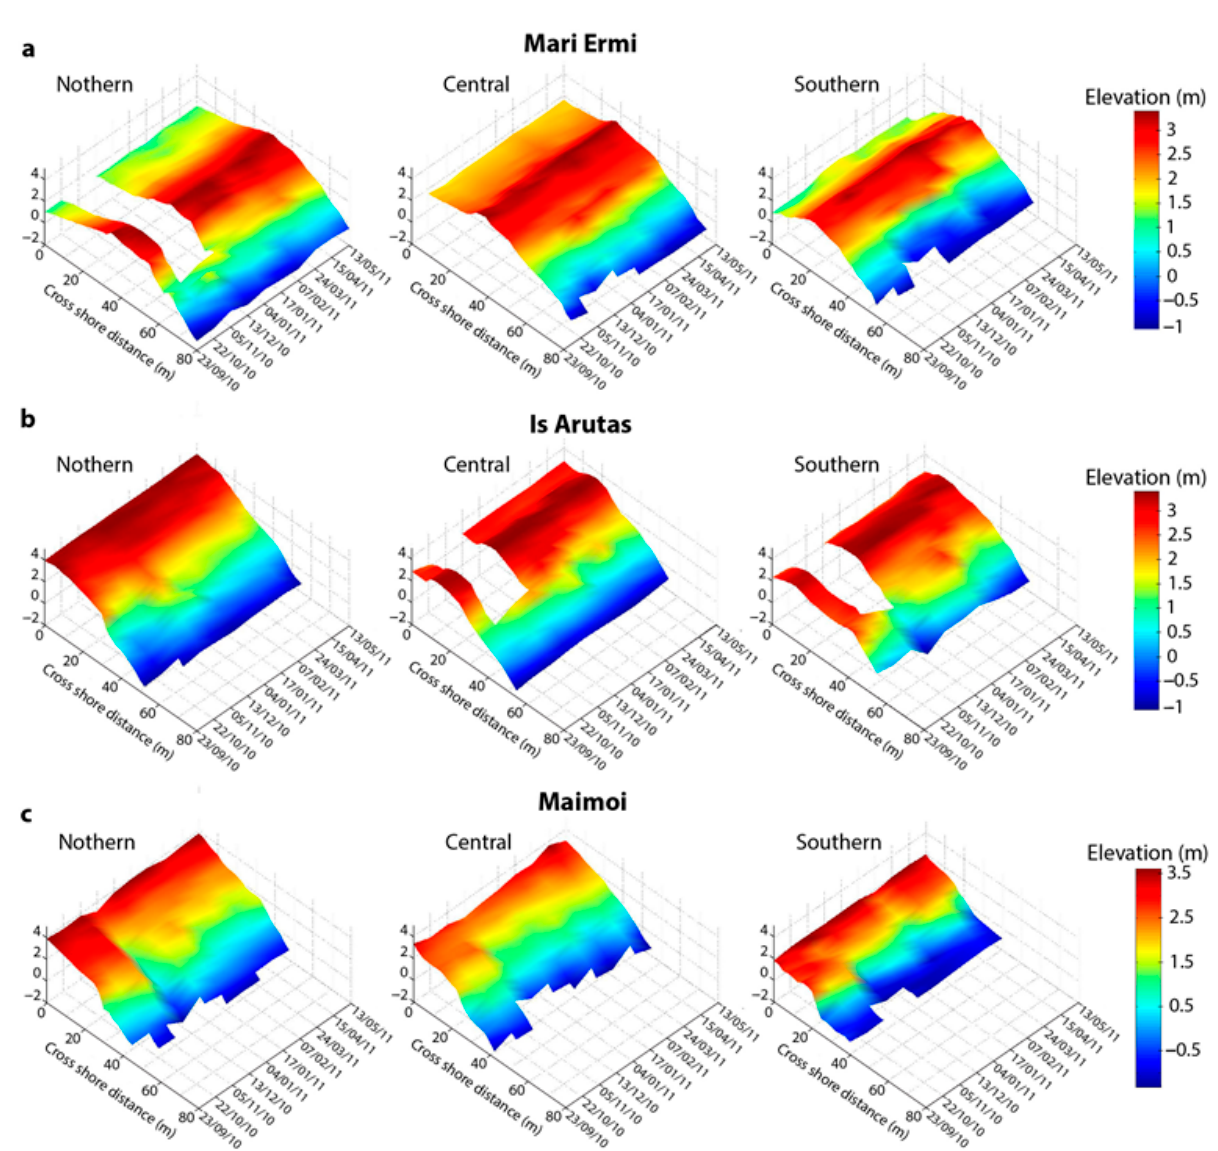
Figure 5. The evolution of the morphology along the beach profiles, as follows: ( a ) Mari Ermi; ( b ) Is Arutas; and ( c ) Maimoi. Where DGPS data were not accurate, the profiles were not represented. X, Y and Z axes represent the date of survey, the cross-shore distance and the elevation recorded during the beach profile acquisition. The elevation data for each survey are side-by-side and no interpolation was performed among them.